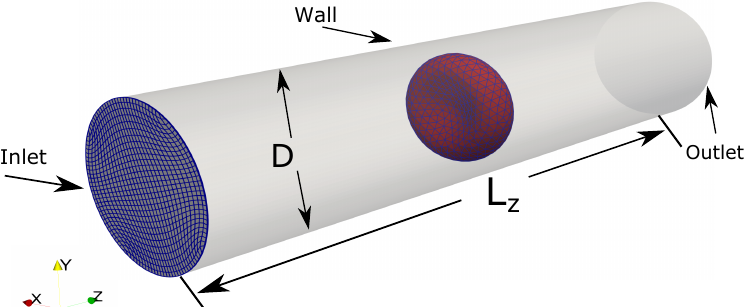
Figure 9. The computational setup for the Fluid-Structure Interaction simulation between a single RBC in a Poiseuille flow. The computational domain (the tube) is a structured mesh of size 31 × 31 × 51 with the average spacing in ( i , j , k ) directions are approximately 0.4 µ m × 0.4 µ m × 0.9 µ m. The curvilinear mesh at the k = 0 plane is shown in blue for an il- lustration of the computational mesh. Time-varied uniform flow is prescribed at the inlet at k = 0. The fully developed boundary is applied at the outlet. Wall boundary (no-slip) condition is applied on the tube wall. The diameter of the tube and its length are D = 10 µ m and L z = 45 µ m, respectively. The RBC model ( N v = 500) is initially placed at the center of the